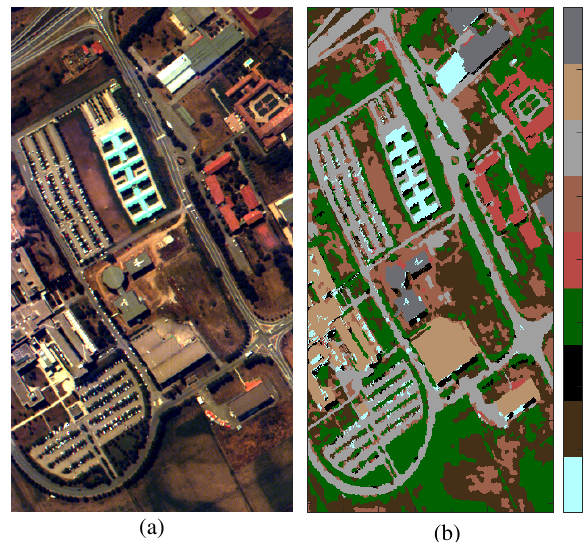
Figure 13. Resulting labeled image. (a) shows the Pavia University scene and (b) the generated labeled